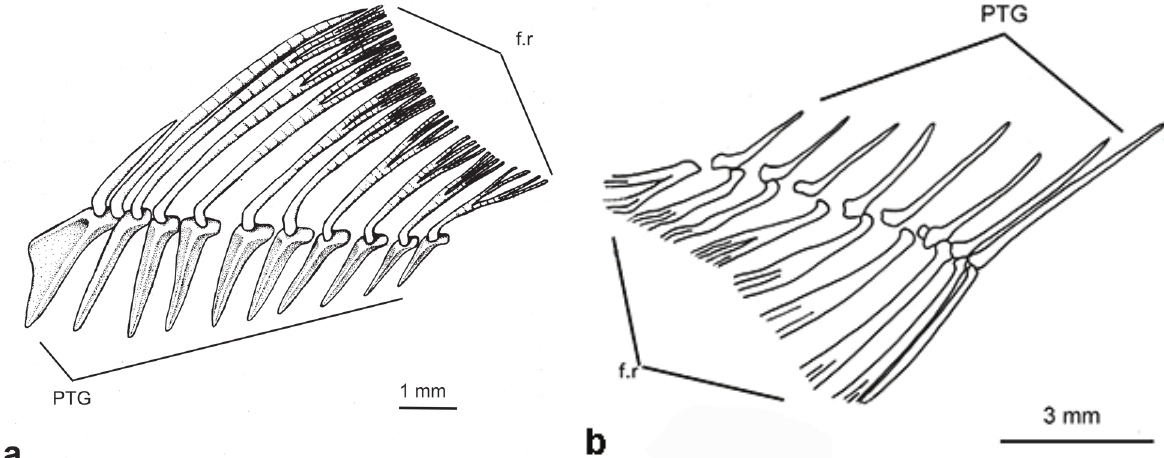
Figure 9 . † Scutatuspinosus itapagipensis Santos and Corrêa 1985: ( a ) dorsal fin and endoskeletal support of DGM 1262-P; ( b ) anal fin and endoskeletal support of DGM